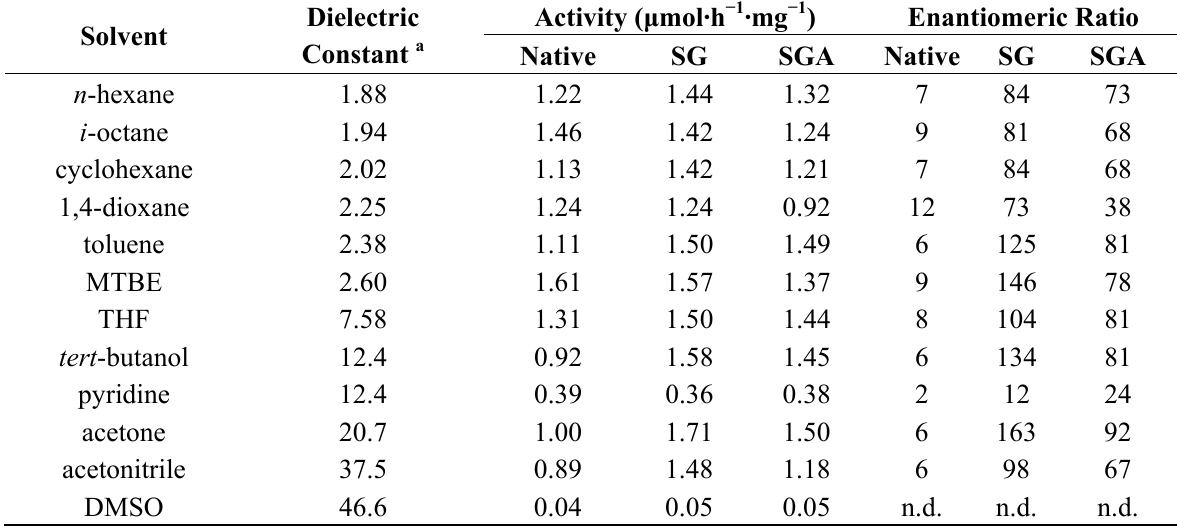
Table 3. Influence of long-time (7 days) incubation at 25 °C, in different organic solvents, on the enzymatic activity of native, sol-gel entrapped (SG), or sol-gel entrapped and adsorbed (SGA) CaLB lipase, assayed for the acylation of 2-octanol, at 6 h reaction